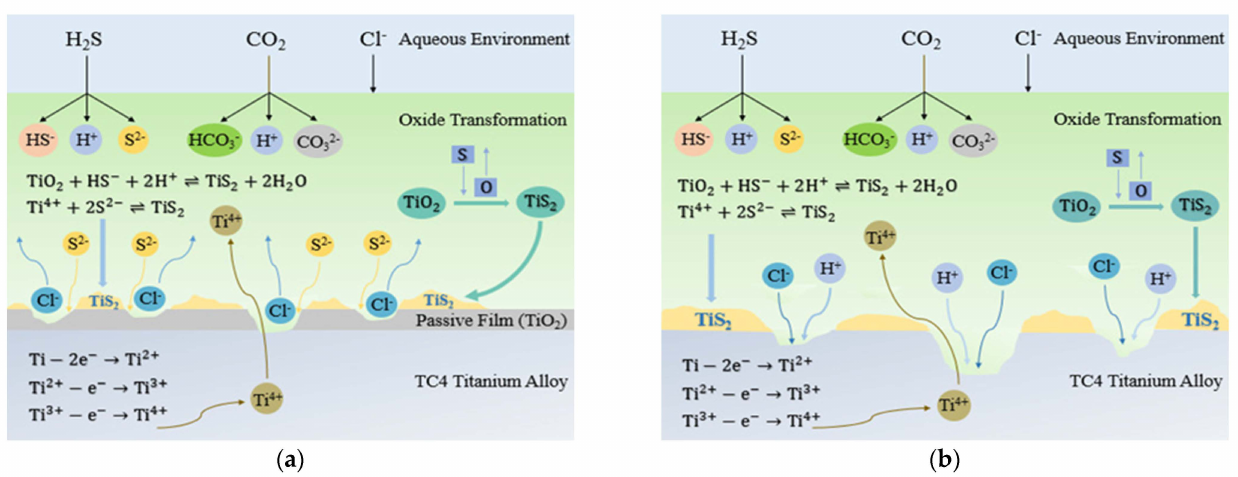
Figure 6. Corrosion mechanism of the TC4 titanium alloy in the CO 2 -H 2 S-Cl − system: ( a ) initial stage and ( b ) latter